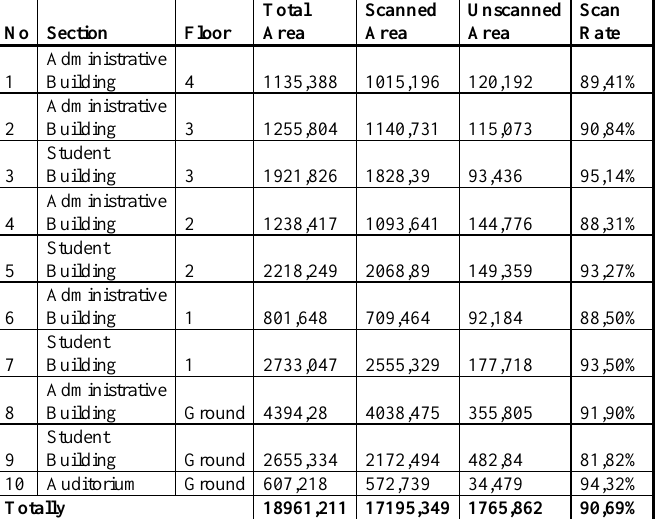
Table 3. Status of the Photogrammetric